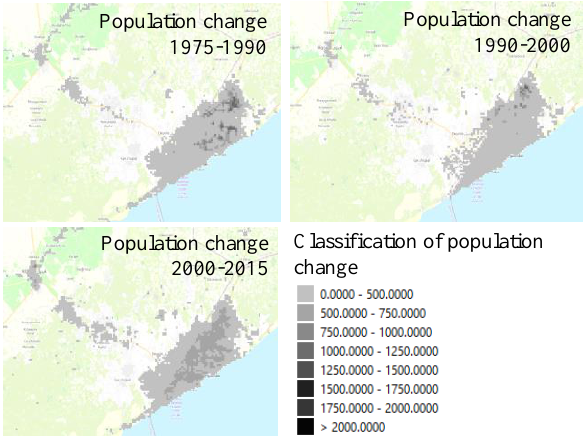
Figure 9. Classification of population change in Mogadishu